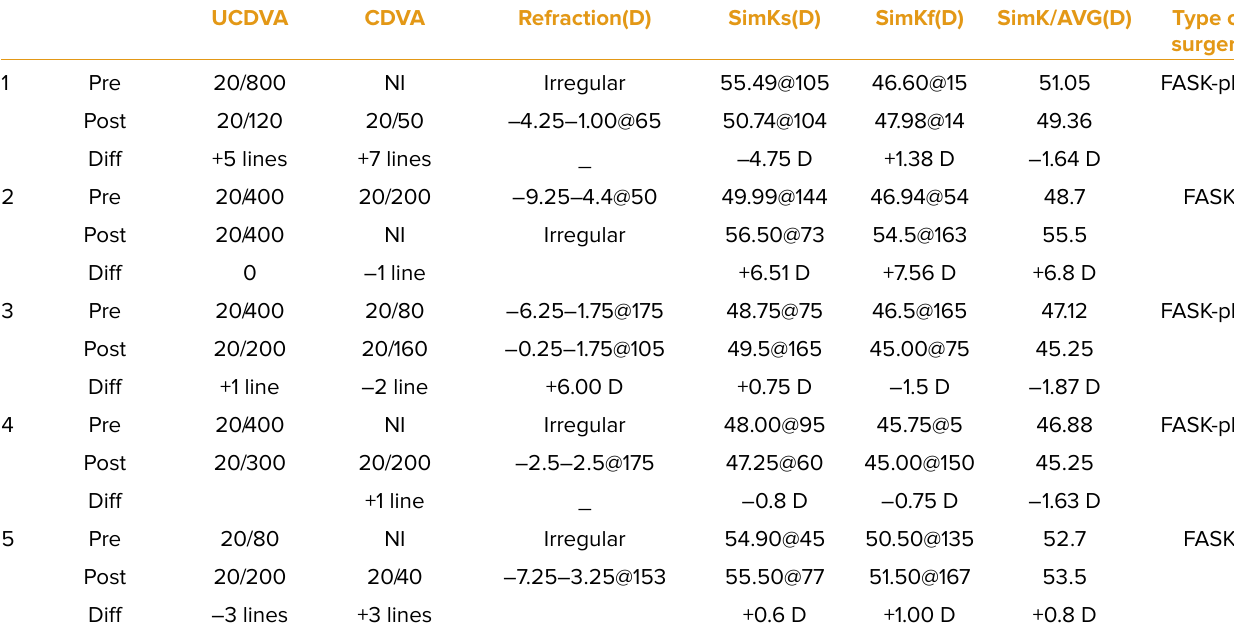
Table 2. Pre- and postoperative visual, refractive, and keratometric values